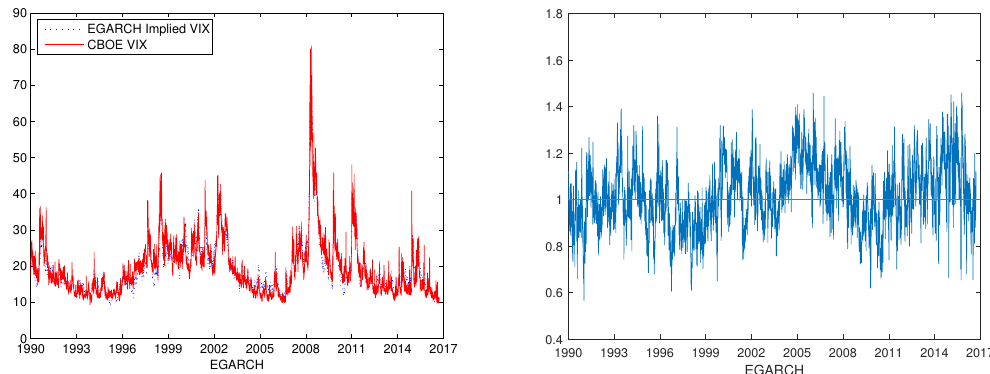
Figure 7. Comparison between CBOE VIX and implied VIX of the EGARCH(1,1) model using VIX data only. The left panel shows the index values of CBOE VIX and implied VIX and the right panel shows the ratio of the implied VIX to CBOE VIX and a horizontal line at 1 for